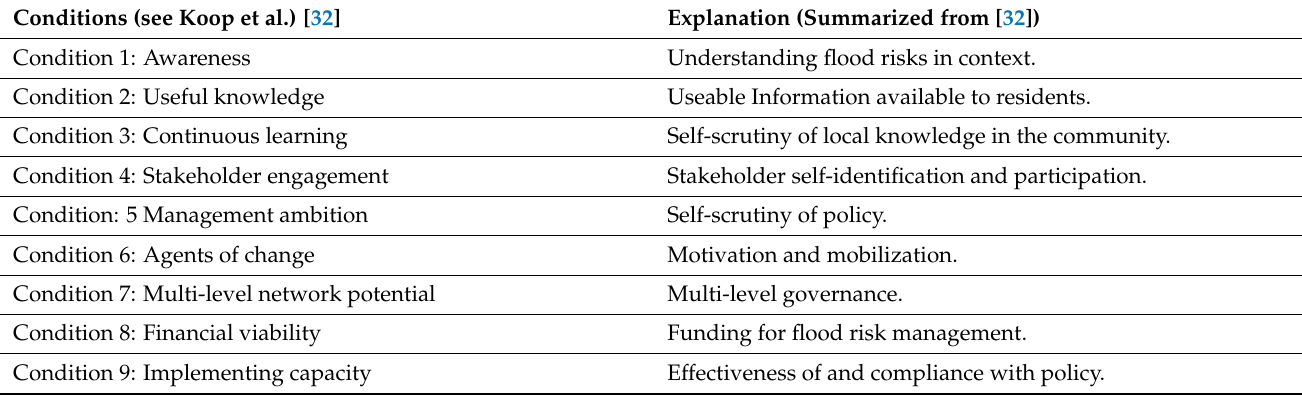
Table 3. Conditions that together determine the capacity of cities to govern water